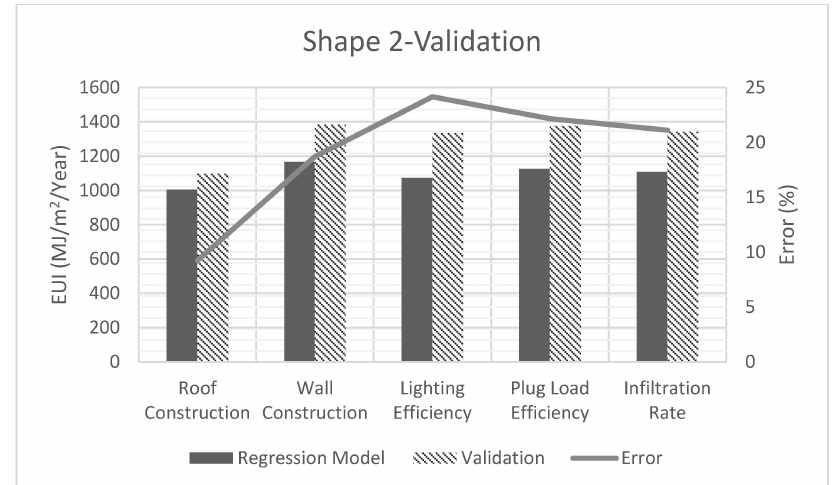
Figure 21. TETB Shape 2 validation.